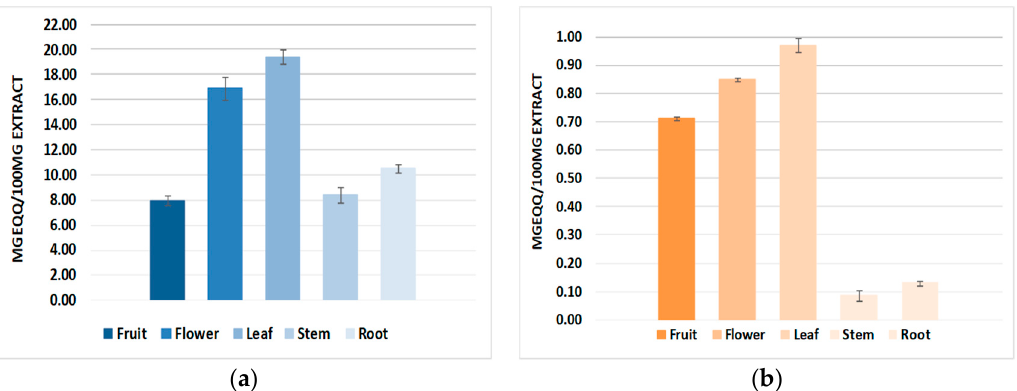
Figure 1. Total concentration of polyphenols ( a ) and flavonoids ( b ) determined from the N. alba methanolic fruit, flower, leaf, stem, and root extracts.